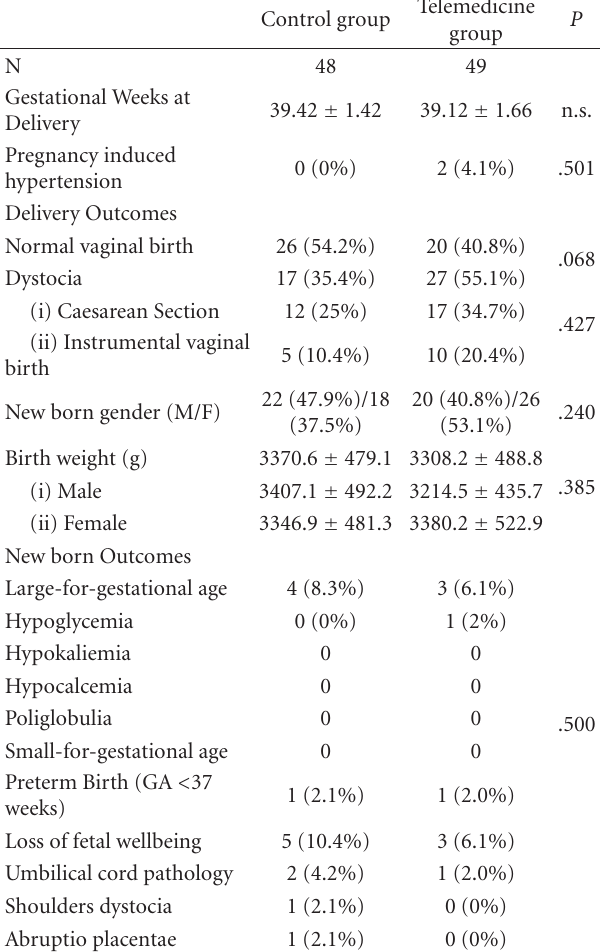
Table 3: Gestation, Delivery and New Born